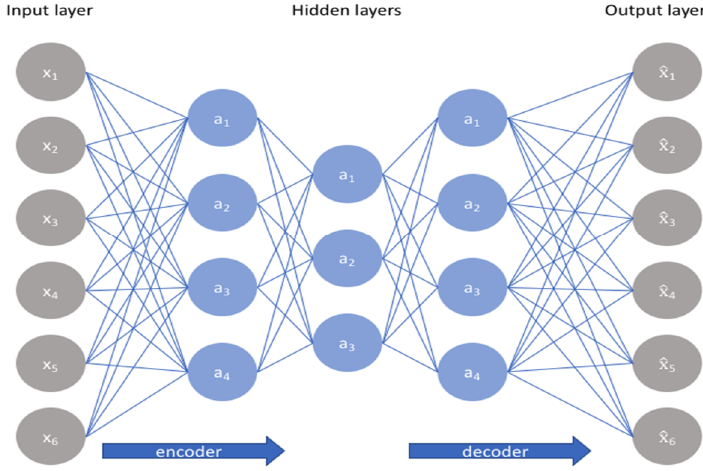
Figure 8. Auto-Encoder Neural Network.